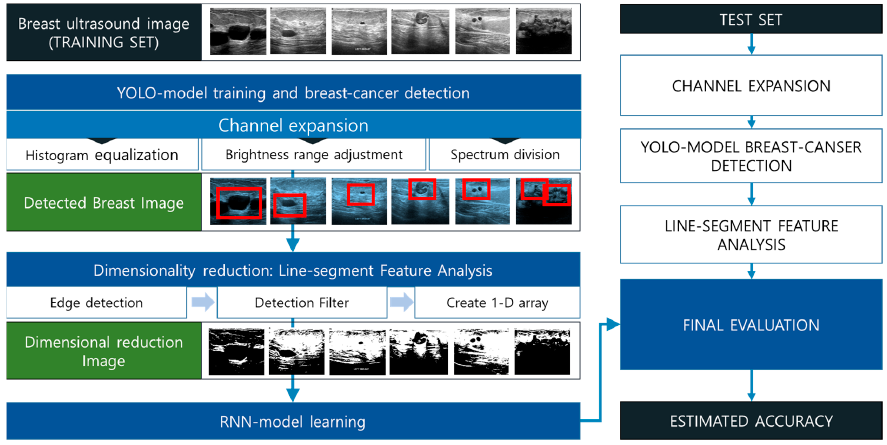
Figure 2. Processing of the multi-model-based image visual pattern standardization and dimensionality reduction algorithm.